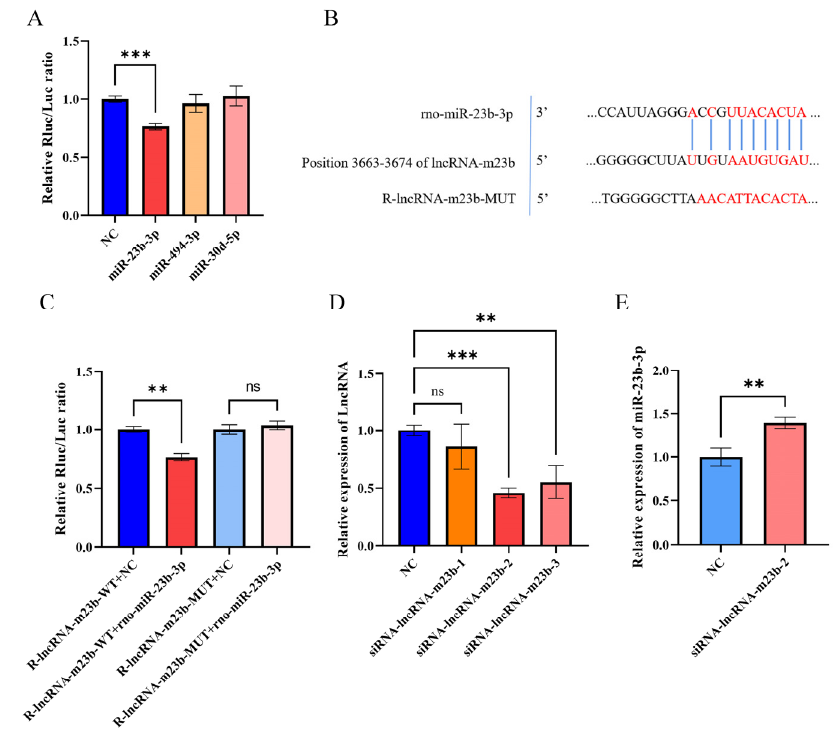
Figure 7. ( A ) Identification of miRNAs that might directly target lncRNA-m23b. ( B ) TargetScan’s anticipated miR-23b-3p base complementary pairing sequence with lncRNA-m23b is highlighted in red. ( C ) Changes in relative luciferase activity after the transfection of plasmids with NC/mimics. ( D ) Screening of siRNAs. ( E ) RT ‒ qPCR after knockdown of lncRNA-m23b. ns, p > 0.05; **, p < 0.01; ***, p < 0.001.